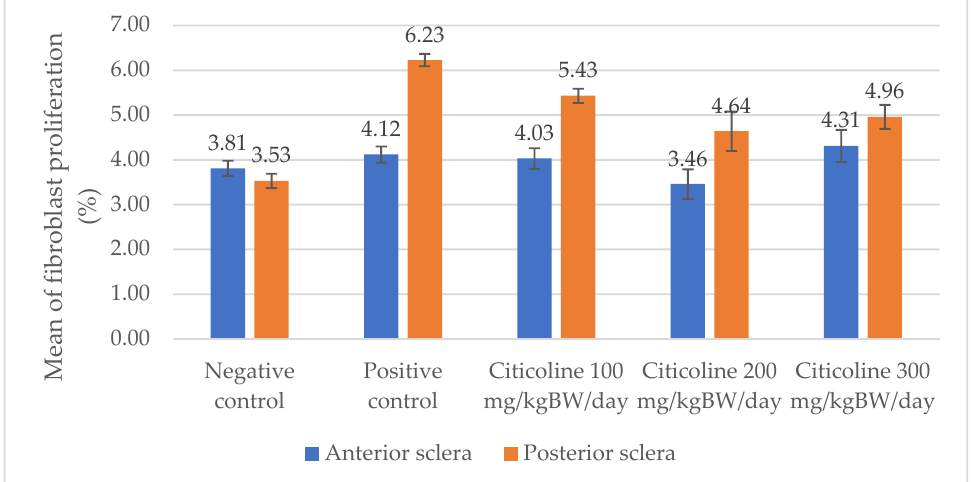
Figure 6. Mean fibroblast proliferation of the rats’ scleral tissue. Based on Tukey test, the positive control group shows a higher level of fibroblast proliferation compared to the negative control group (4.12 ± 0.18 vs. 3.81 ± 0.17, p = 0.227, in the anterior sclera and 6.23 ± 0.14 vs. 3.53 ± 0.16, p = 0.000, in the posterior sclera). Among the treatment groups, the treatment group administered with 200 mg/kg BW/day shows the lowest level of fibroblast proliferation compared to the positive control group (3.46 ± 0.33 vs. 4.12 ± 0.18, p = 0.001 in the anterior sclera and 4.64 ± 0.44 vs. 6.23 ± 0.14, p = 0.000 in the posterior sclera).